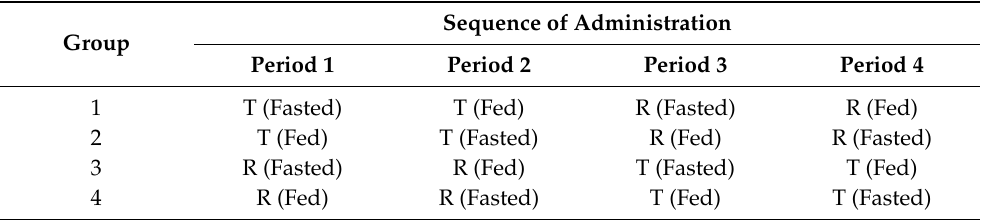
Table 2. Sequence of administration of floating tablet and reference tablet under fasted and fed conditions. Sequence of Administration Group Period 1 Period 2 Period 3 Period